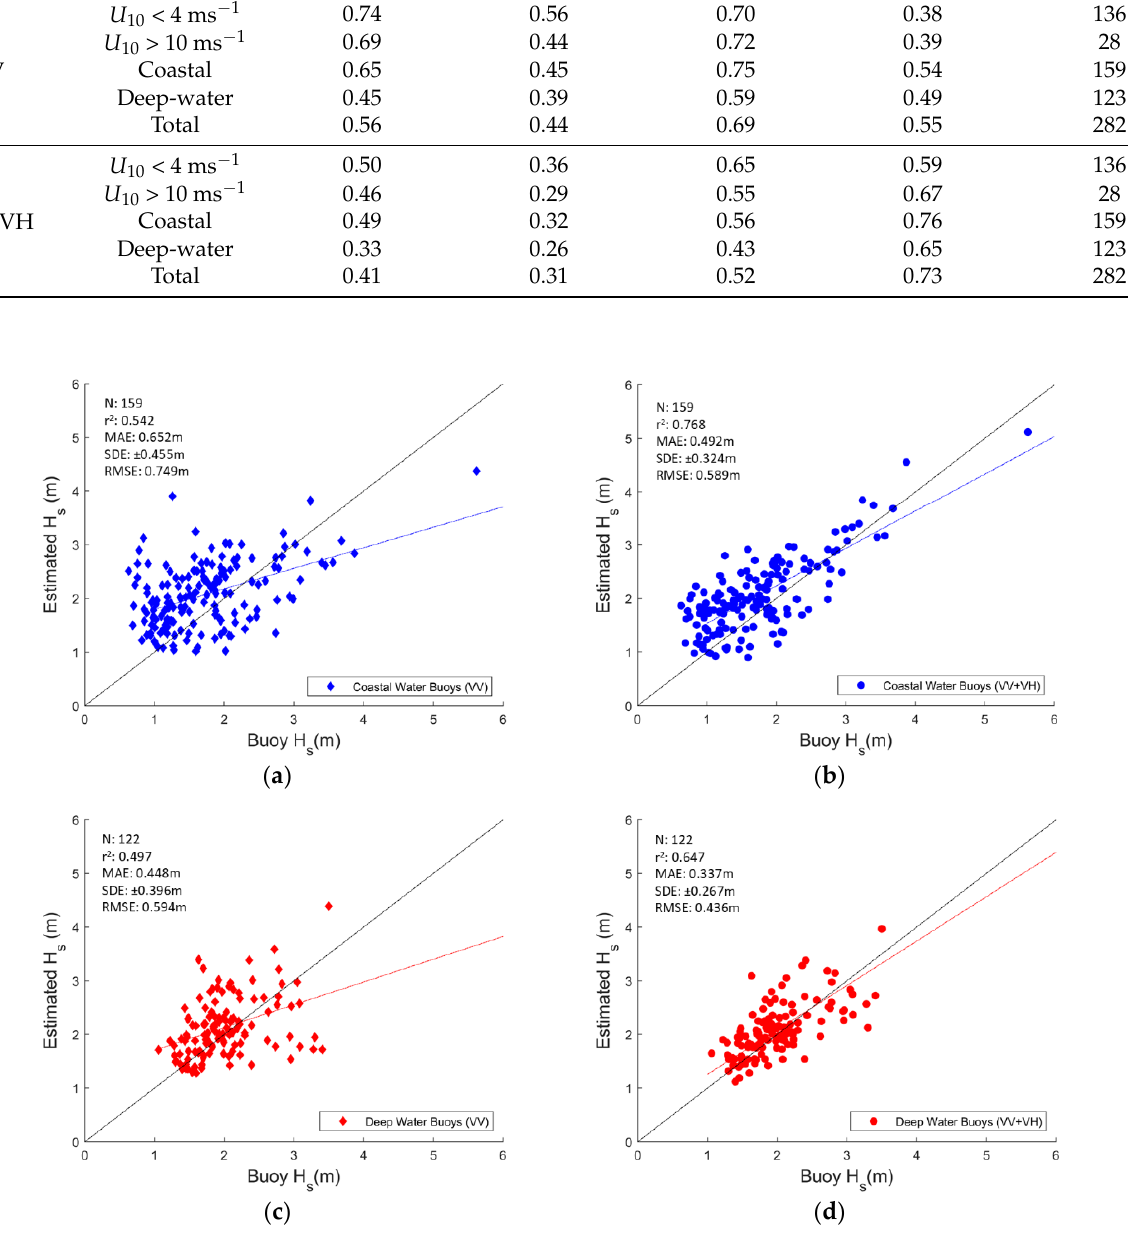
Figure 6. Comparisons of the H s estimation using both coastal ( a , b ) and deep water SAR images ( c , d ) using VV and VV + VH polarizations, respectively.